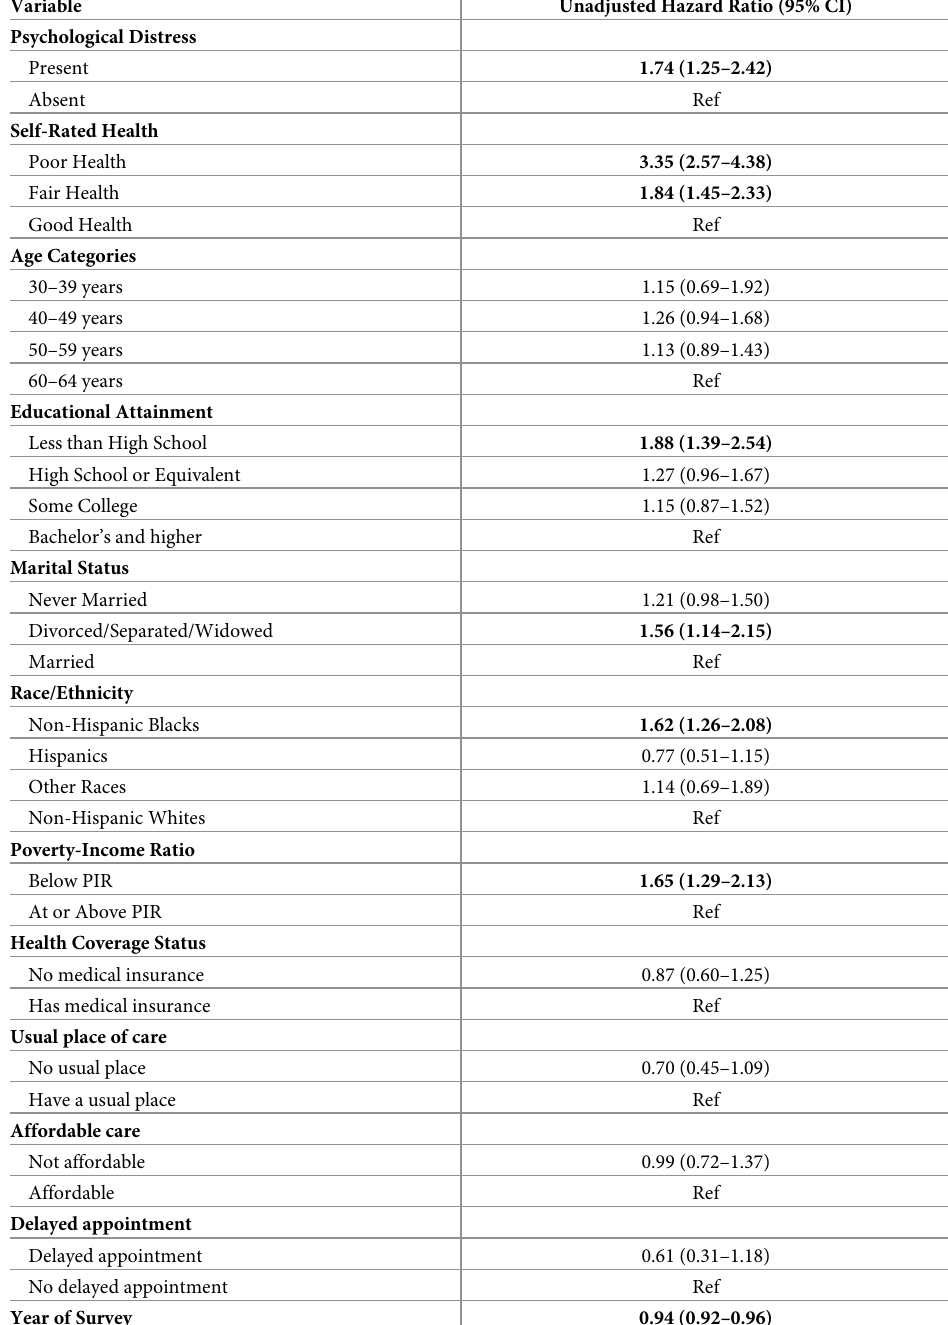
Table 2. Unadjusted hazard risk ratios of the predictor variables on the mortality from breast